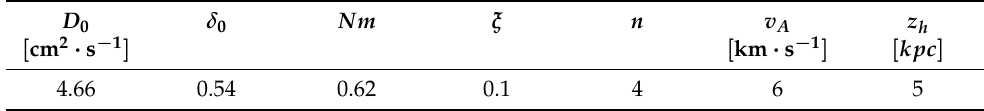
Table 1. Fitted spatial-dependent propagation